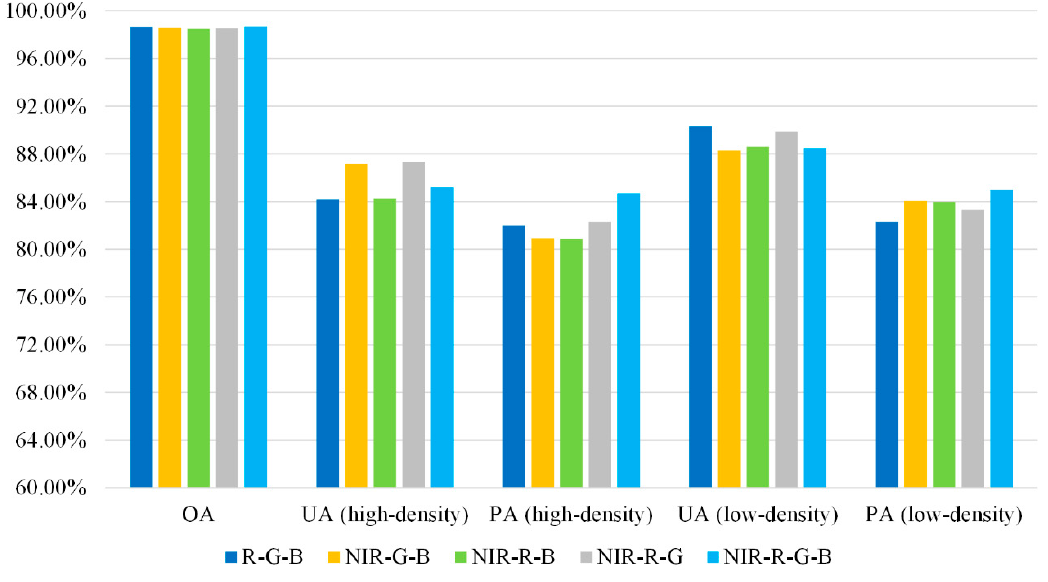
Figure 7. Accuracy assessment of different data input strategies.